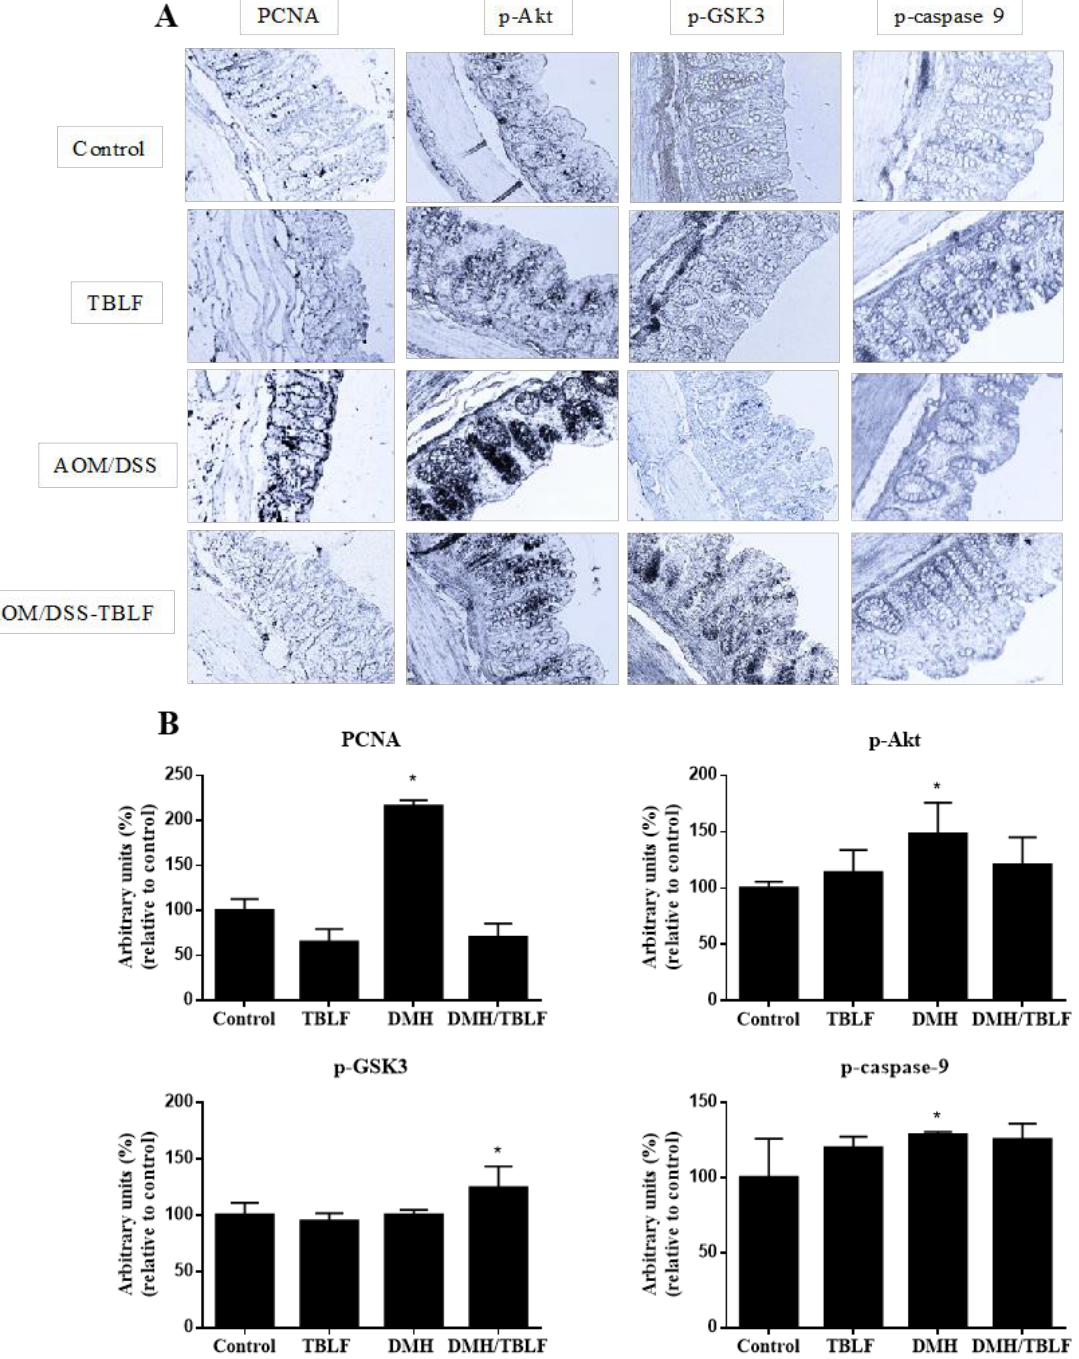
Figure 7. Immunohistochemical analyses of the proliferation and Akt-pathway targets in colon lesions provoked by AOM/DSS and treated with TBLF. Rats were intraperitoneally administered for two weeks with AOM and a further two weeks with DSS in their daily drinking water to develop ACF. Next, they were administered with TBLF (50 mg/kg) on alternate days for six weeks via intra-gastric cannula. ( A ) Representative micrographs of each group (10 × ); ( B ) Densitometry analyses of immuno-stained colon tissues. (*) Significant difference by one-way ANOVA (Dunnett p < 0.05).